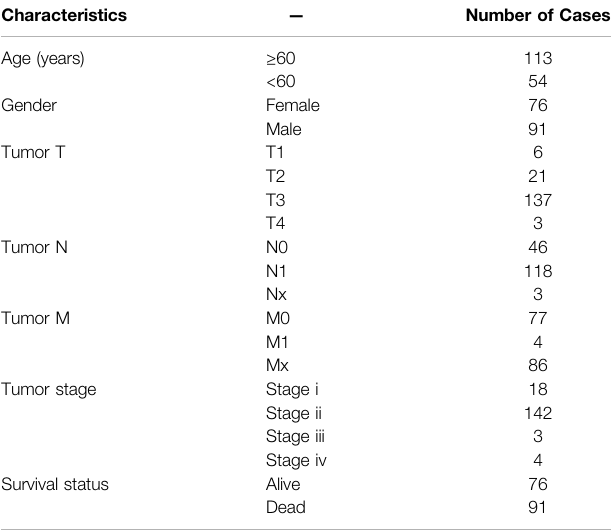
TABLE 1 | Patient characteristics in the TCGA-PAAD